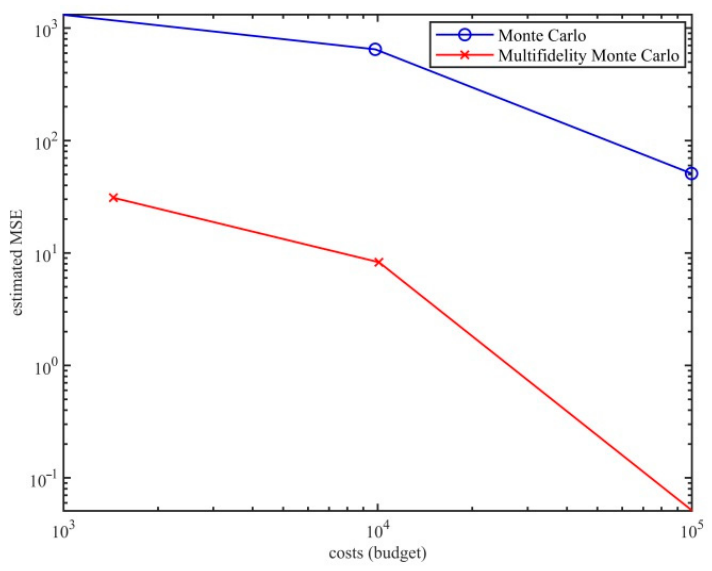
Figure 2. The budgets of estimated MSE for the standard MC and MFMC estimators range from p = 10 3 to 10 5 .